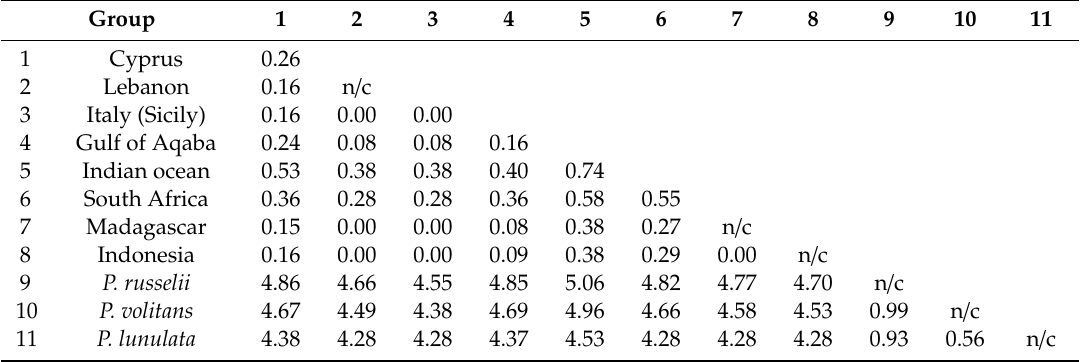
Table 1. Percentage sequence divergence (p-distance) among taxa and / or geographical groups for the COI gene. Values at the diagonal are within group distances. Group